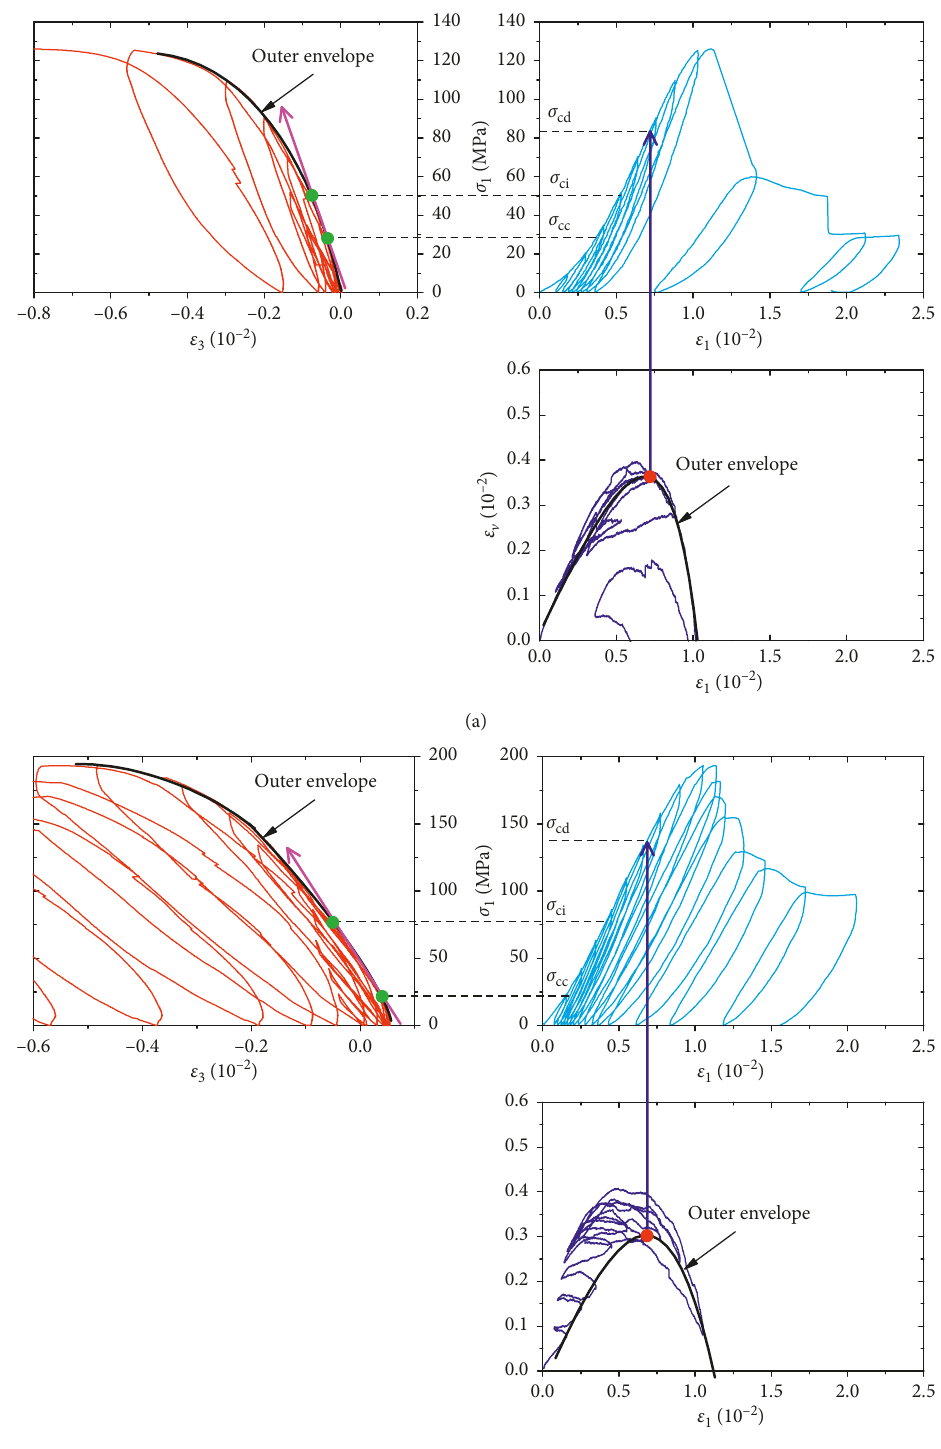
Figure 10: Determination process of characteristic stress by LSM and VSM with the confining pressures of 5MPa (a) and 20MPa